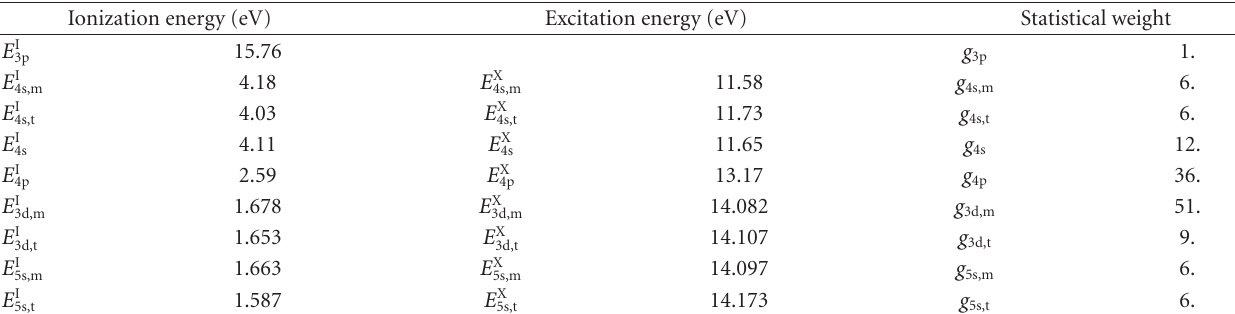
Table 1: Structure description of the averaged states of Ar I included in the